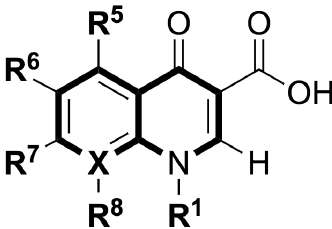
Figure 1. Shared core scaffold of quinolone antibacterial compounds. X = N indicates 1,8-naphthyridine, X = C defines quinolones. R 6 = F defines fluoroquinolones.